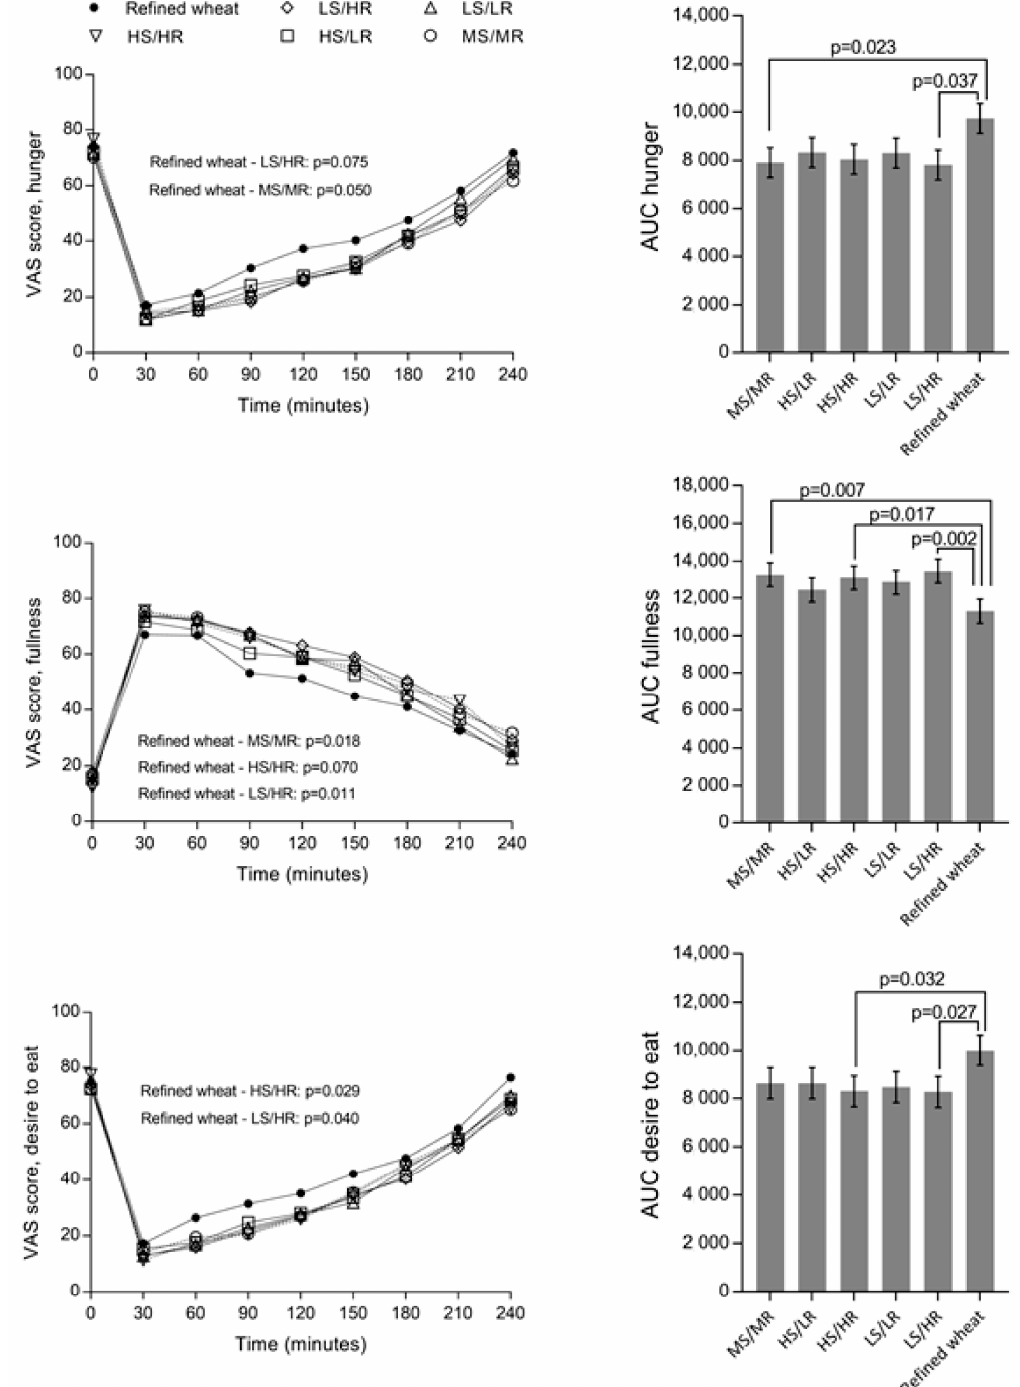
Figure 3. Appetite ratings following consumption of breads with varying content of rye and sourdough and a refined wheat control as part of a breakfast meal ( left ). AUC of appetite measures ( right ) are baseline adjusted least square means with standard error of mean. p -values are the result of pairwise comparisons between diets in an ANCOVA, after Tukey adjustment for multiple comparisons. p -values in the left column stems from pairwise comparisons in a repeated measures ANCOVA, after Tukey adjustment for multiple comparisons. Abbreviations: VAS, visual analogue scale; AUC, area under the curve; MS/MR, medium sourdough/medium rye; HS/LR, high sourdough/low rye; HS/HR, high sourdough/high rye; LS/LR, low sourdough/low rye; LS/HR, low sourdough/high